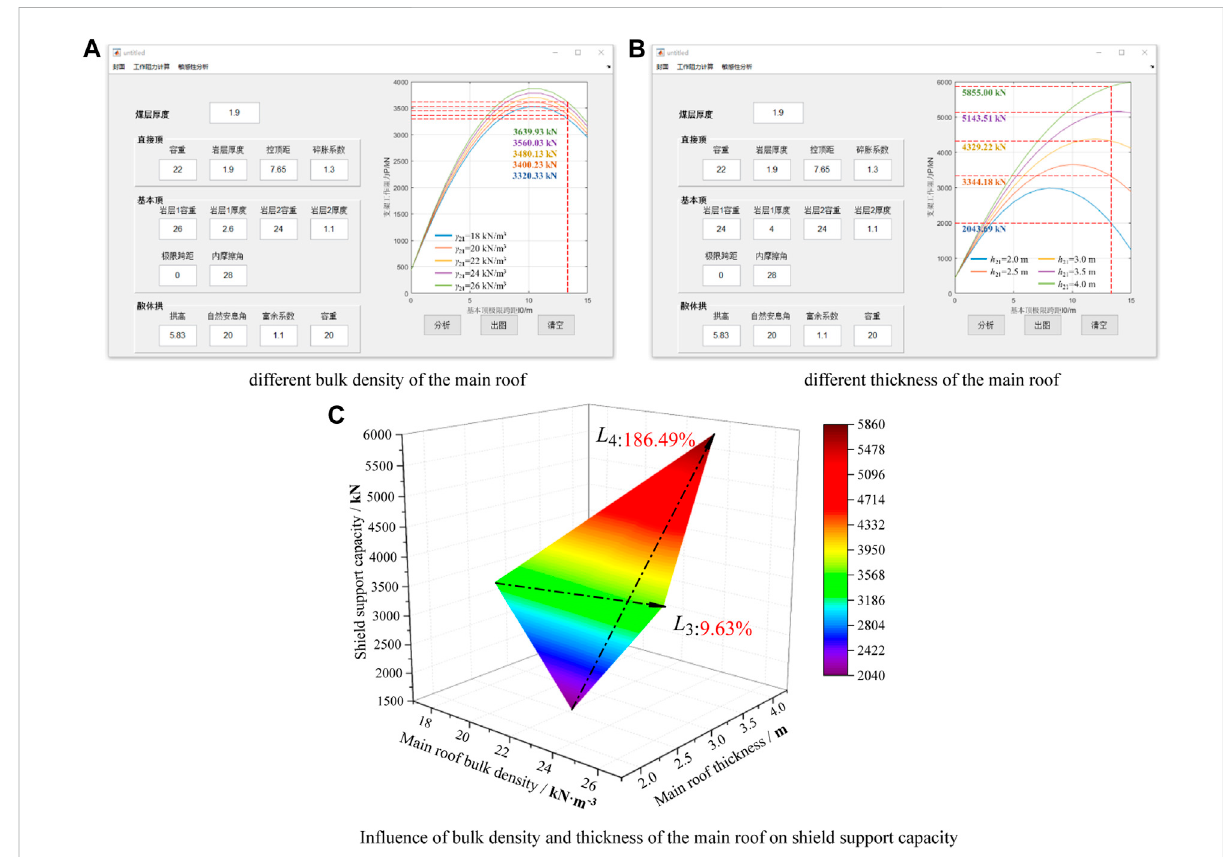
FIGURE 10 Relationship between related parameters of the main roof and shield support